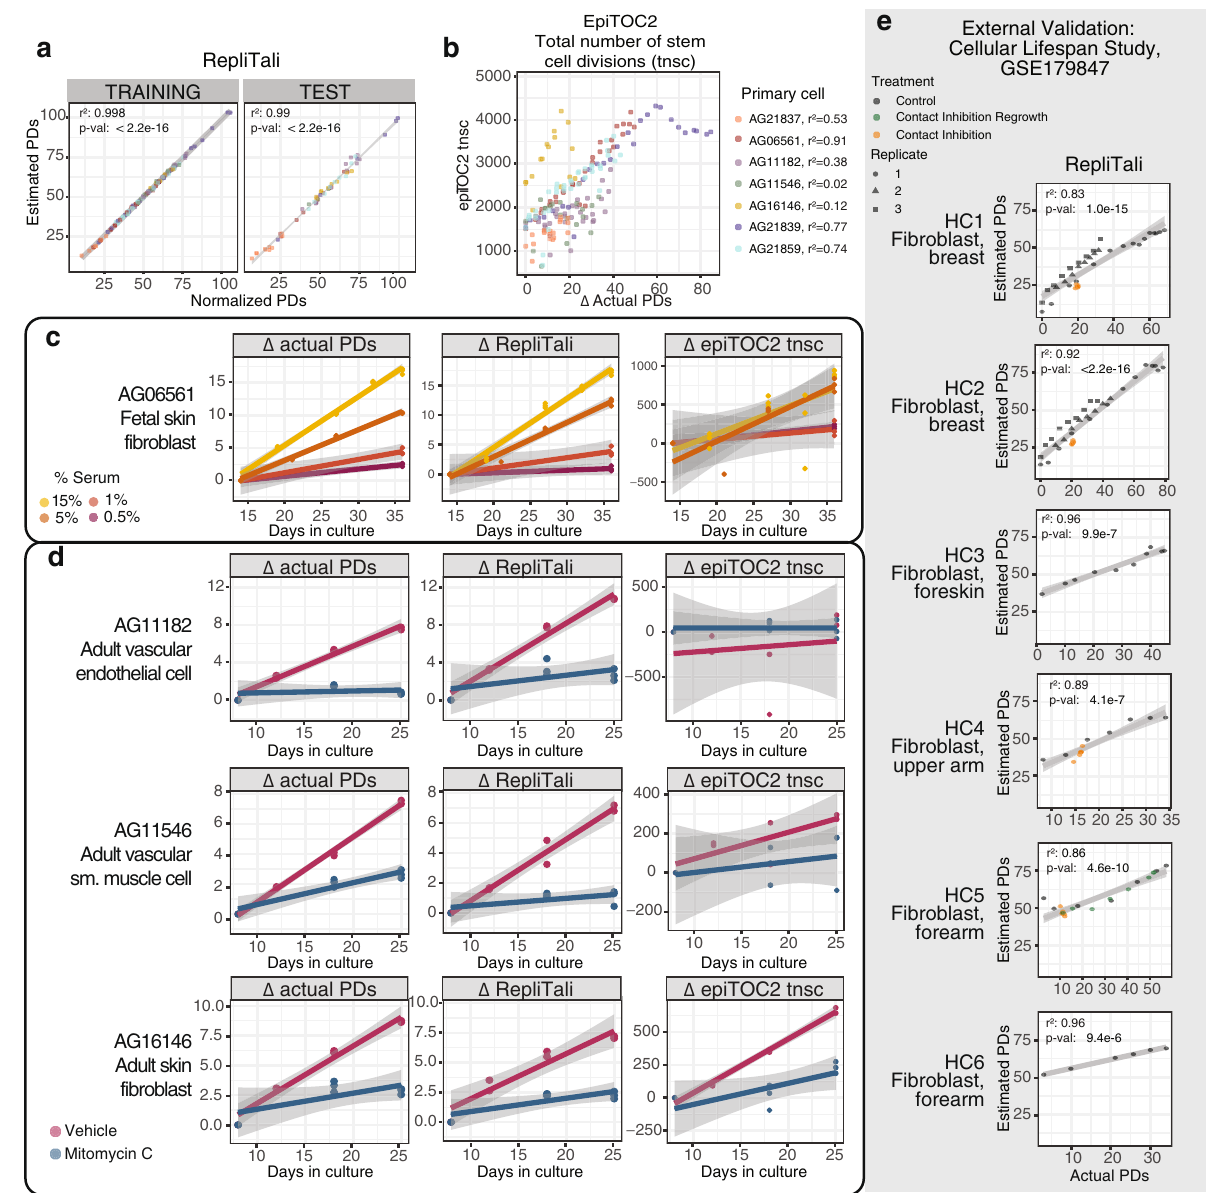
Fig.4|ConstructionandperformanceofRepliTali.a PerformanceofRepliTalion randomized training ( n =122) and test ( n =60) sets. Population doublings (PDs) were normalized using a model trained on chronologically youngest cell AG06561 tocorrectthestartingpassagePD,withthechangeinactualPDaddedtothisvalue for subsequent datapoints. Solid lines depict linear regression with gray shading depicting95%con fi denceinterval. b PerformanceofepiTOC2,ahypermethylation- based mitotic clock, on primary cell culture DNA methylation data. c Model